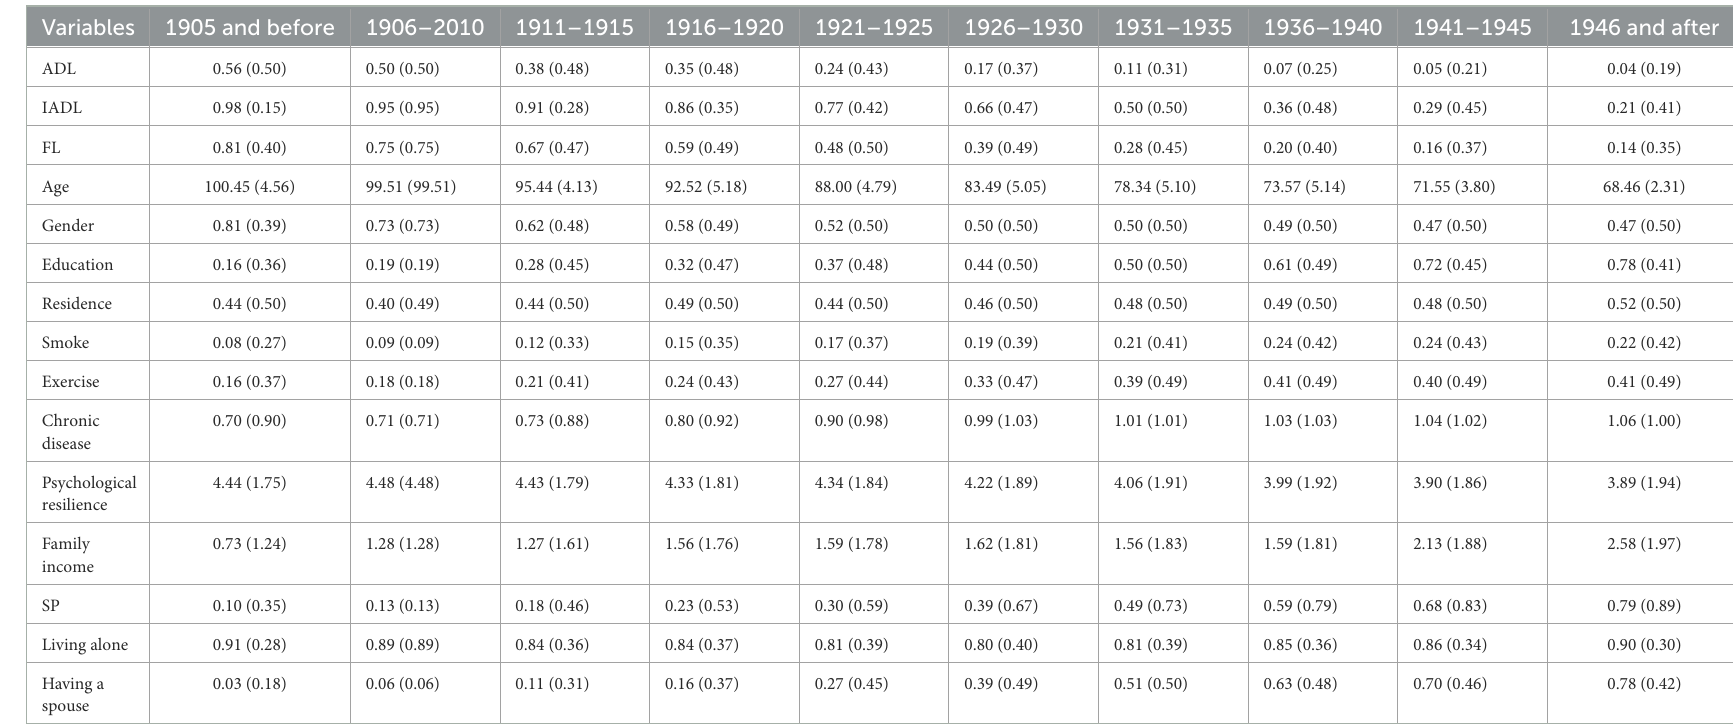
TABLE 1 The sample descriptive characteristics based on